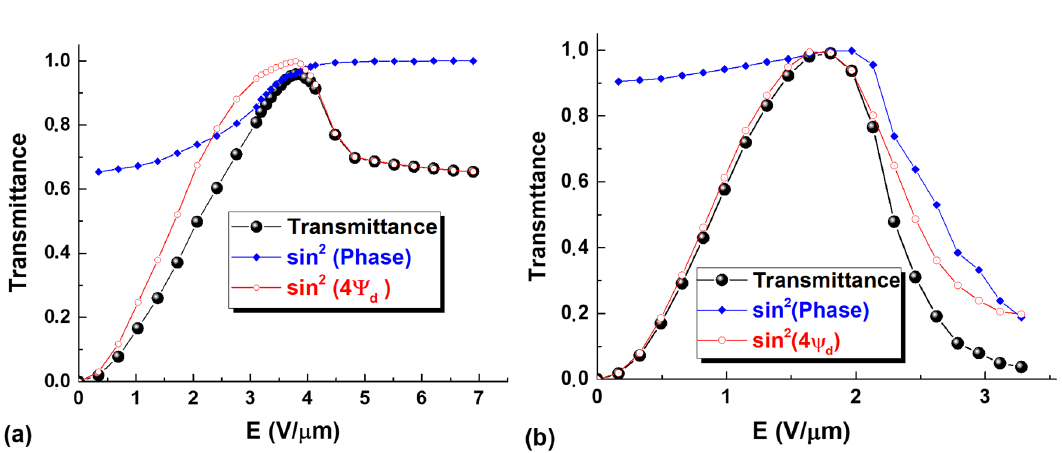
Figure 4. ( a ) Measured total light transmittance T(E) (black balls) and calculated values of the factors included in the relation (2) for the DHFLC cell filled with the FLC-587-F7 at d = 1.45 µ m and placed between crossed polarizers; ( b ) the same data but for the FLC-650 at d = 3.05 µ m. Calculated components of the transmittance are shown by red circles and blue diamonds. Measurements were carried out at 22 ◦ C, at a wavelength of λ = 632.8